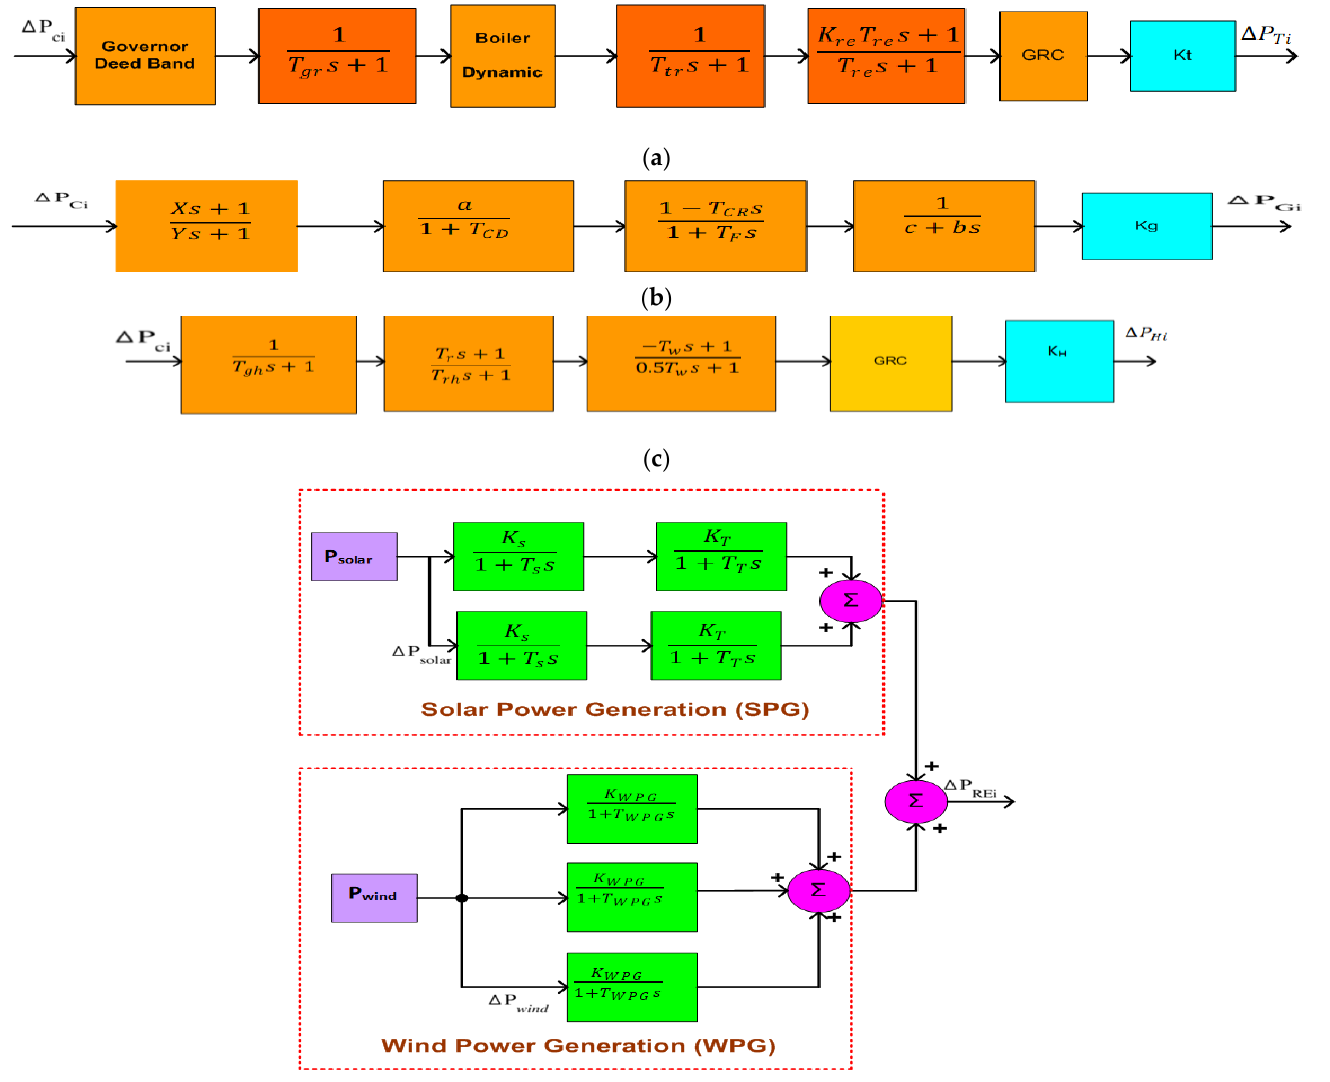
Figure 3. TF model for; ( a ) reheat thermal, ( b ) gas, ( c ) hydro, ( d ) RES.